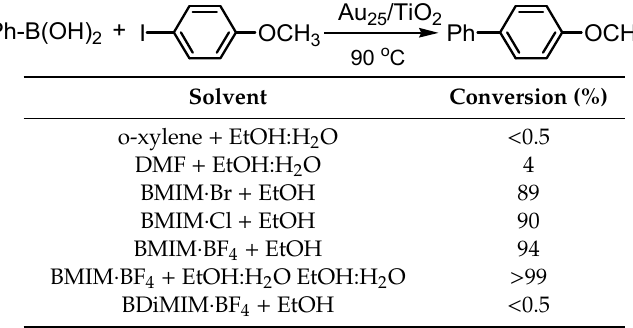
Table 3. Catalytic results over the Au 25 /TiO 2 catalysts in the Suzuki cross-coupling reactions of iodoanisole and phenylboronic acid using the imidazolium-based ionic liquids. Reaction conditions: 0.1 mmol iodoanisole, 0.12 mmol phenylboronic acid, 0.36 mmol K 2 CO 3 , 100 mg Au 25 (SR) 18 /TiO 2 (~1wt % cluster loading), solvents (1 mL EtOH or EtOH:H 2 O (10:1, v/v), and 0.2 mL IL or other organic solvents), 90 °C, 18 h.